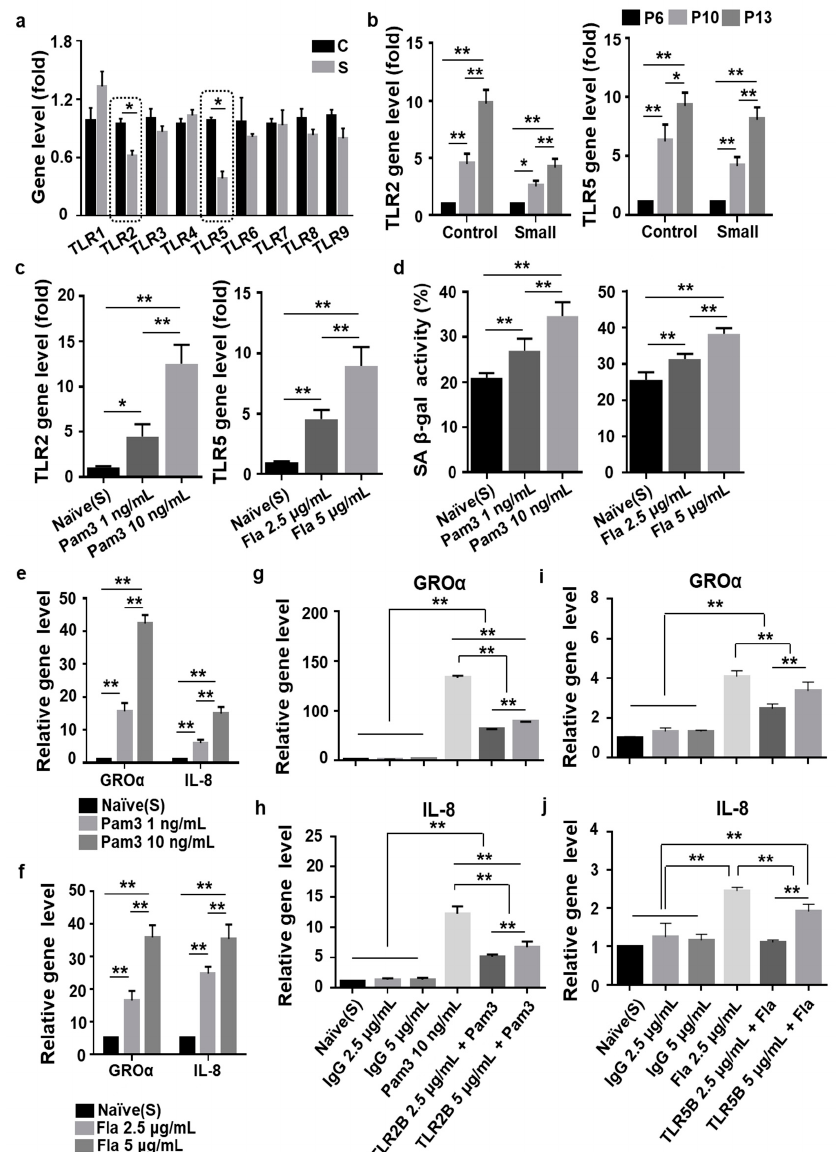
Figure 5. Toll-like receptor 2 (TLR2) and TLR5 activation induce the senescent phenotype in MSCs and were both decreased in small cells: ( a ) Quantification of gene expression levels of TLRs (1~9) in small cells or control cells at P13. Both TLR2 and TLR5 exhibited significantly lower expression in small cells compared to that in control cells (black box); ( b ) to confirm whether TLR2- (left panel) and TLR5-mediated signaling (right panel) in control and small cells is linked to the induction of cellular senescence; ( c , d ) We treated cells with different concentrations of Pam3 or Fla for 48 h; ( c ) quantification of gene expression levels of TLR2 (left panel) or TLR5 (right panel) in Pam3-treatment or Fla-treatment. Expression levels were normalized to those of ß -actin, with the expression level in naïve cells defined as 1; ( d ) cells were stained for SA β -gal, and activity was measured by counting the positively stained cells; ( e , f ) Gene expression of GROa ( e ) and IL-8 ( f ) in small cells treated with Pam3 or Fla was detected using qPCR; ( g , h ) Real-time PCR analysis of gene expression (GROa or IL-8) in small cells at P13 treated with isotype control IgG, TLR2 blocking (TLR2B), or TLR5 blocking (TLR5B) antibody in addition to Pam3 or Fla; ( e – h ) expression levels were normalized to those of β -actin, with the expression level in naïve cells defined as 1; ( a – h ) results are presented as mean ± SD, n = 3 per group. * p < 0.05. ** p < 0.01. C, control cells; S, small cells; P, passage; GROa, growth-regulated oncogene-alpha; IL-8, interleukin-8; toll-like receptor 2 blocking, TLR2B; toll-like receptor 5 blocking, TLR5B; SA β -gal staining; senescence-associated β -galactosidase staining; rhGROa, recombinant human GROa; rhIL-8, recombinant human